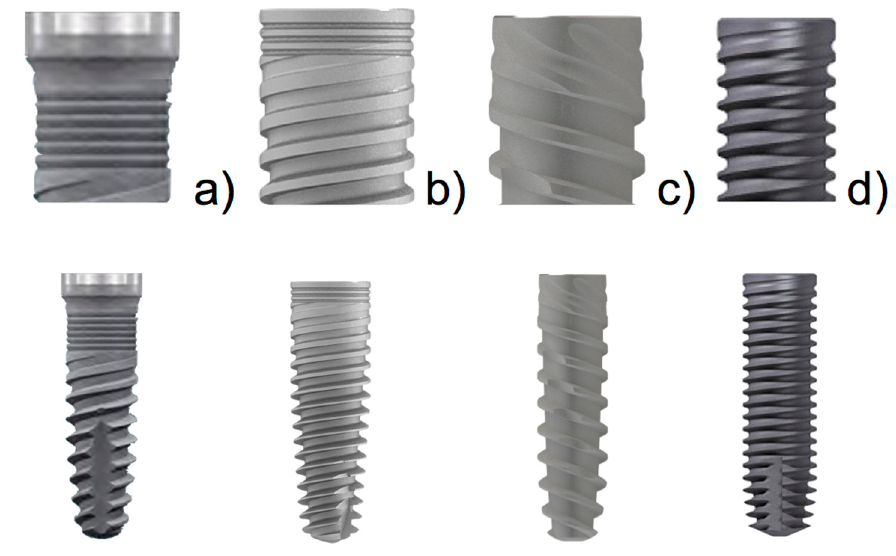
Figure 1. Implants used in the experiment: ( a ) Blue Sky, Bredent ® ; ( b ) C1, MIS ® ; ( c ) IPX, Galimplant ® ; and ( d ) Facility, Neodent ® .